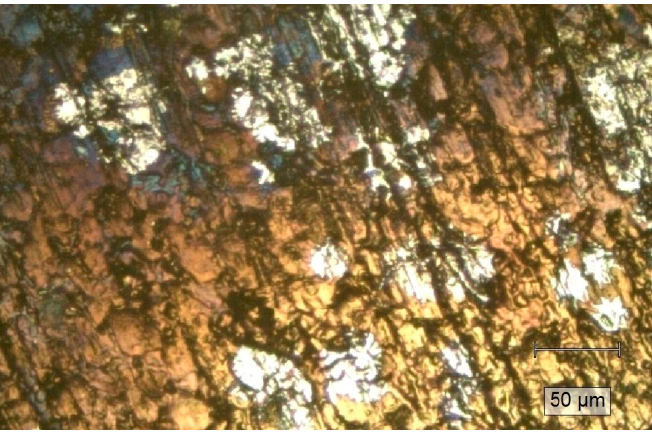
Figure 12. Surface microstructure of W 70 Cu 30 after electrical strength tests were performed.